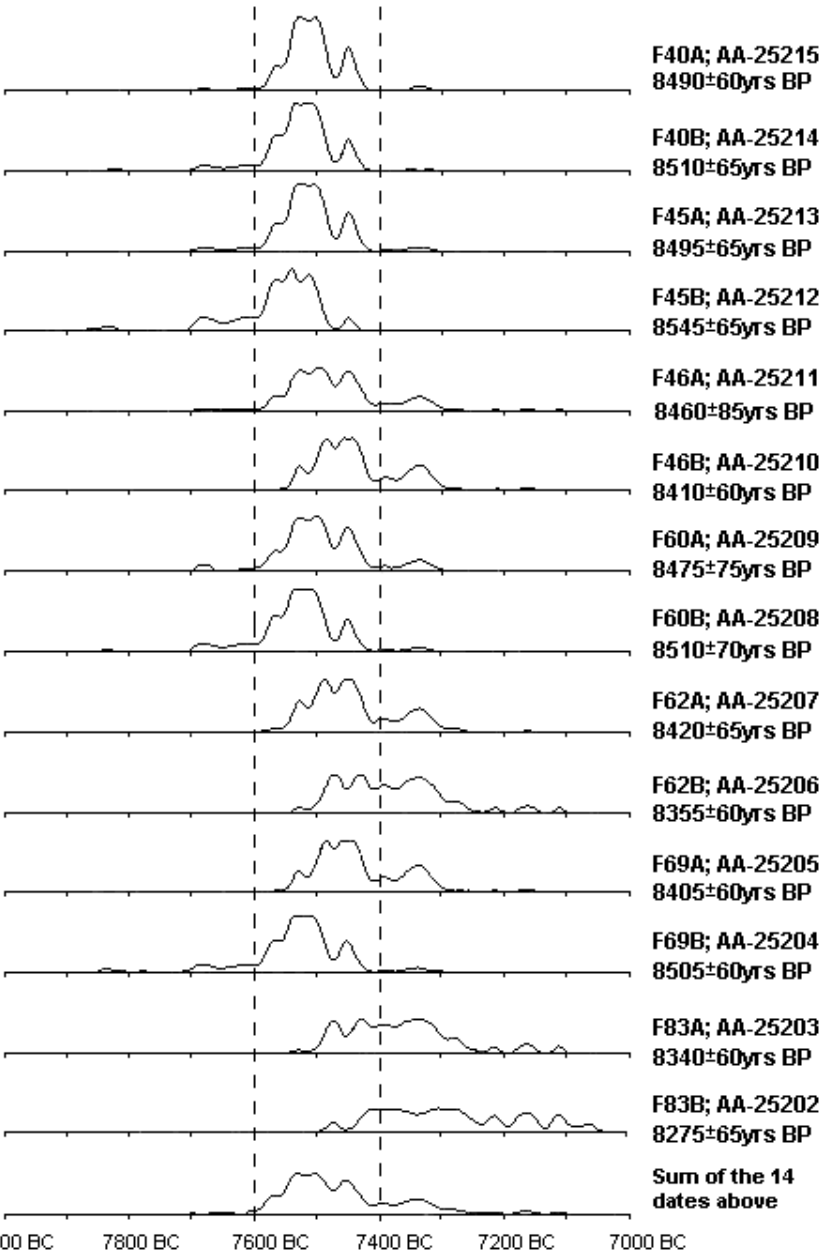
Figure 5: The probability distributions of the calibrated Fife Ness dates The probability distributions of the calibrated dates are shown in Figure 5. The dates were calibrated using the calibration data published by Stuiver and Reimer 1993. The curve is fairly steep in the region between 8350 BP and 8650 BP (Figure 6) which is reflected in fairly precise calibrated dates. As